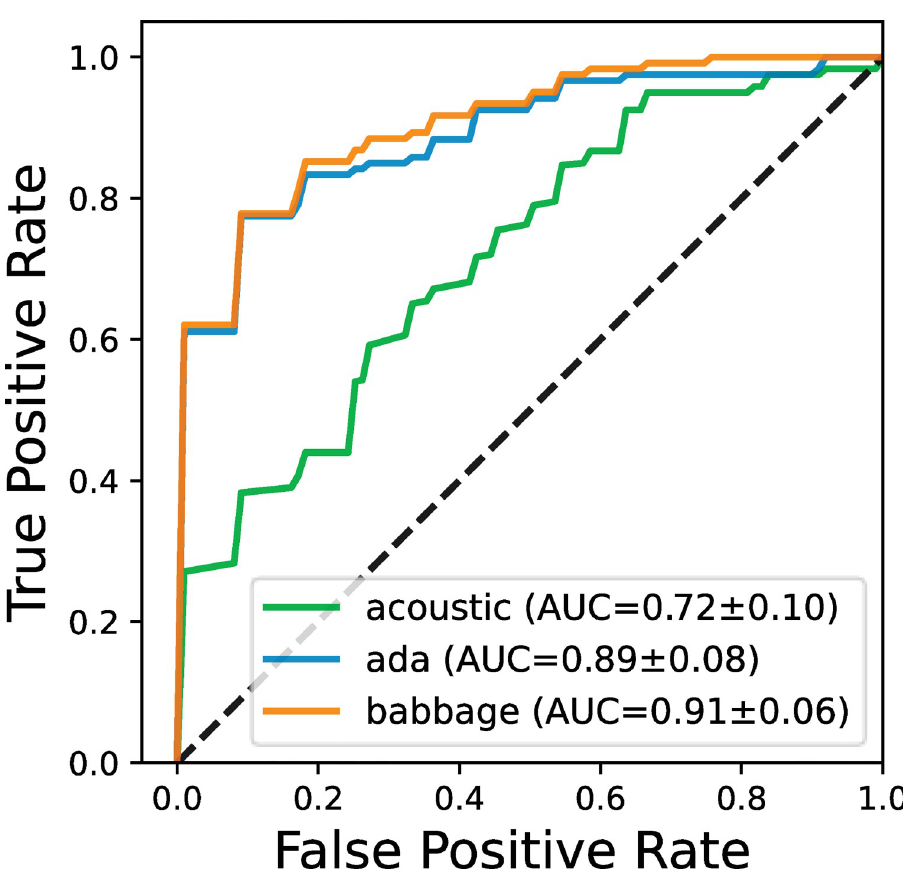
Fig 2. ROC curves, along with the averaged AUC scores and standard deviations, obtained by the 10-fold CV for the best acoustic, Ada and Babbage embedding models.